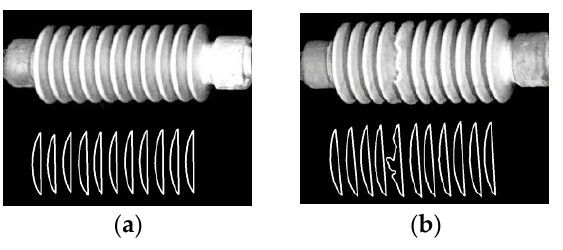
Figure 11. Some test images and contour extraction results. ( a ) Normal insulator and its contour extraction results; ( b ) Damaged insulator and its contour extraction results.